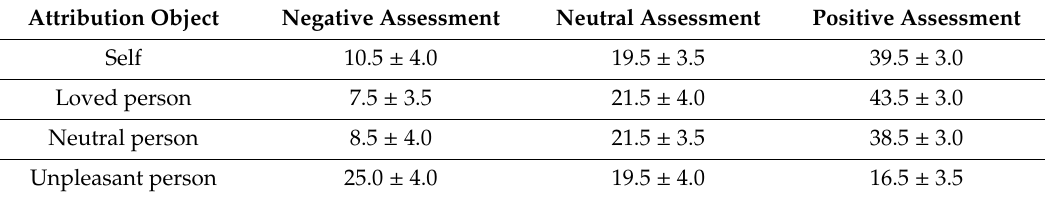
Table 2. The average number of choices for di ff erent attribution’s objects and assessments.